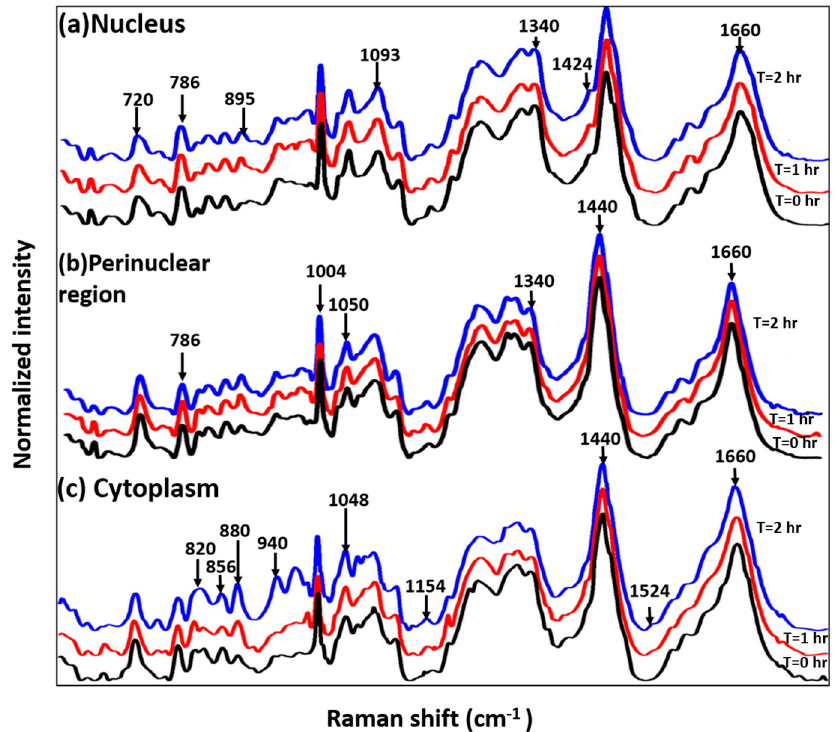
Figure 3. Mean baseline corrected spectra extracted from individual clusters annotated to an intracellular region in cluster Raman image: ( a ) Nucleus; ( b ) Perinuclear Region; and ( c ) Cytoplasm. Spectra are vertically offset for better visibility.